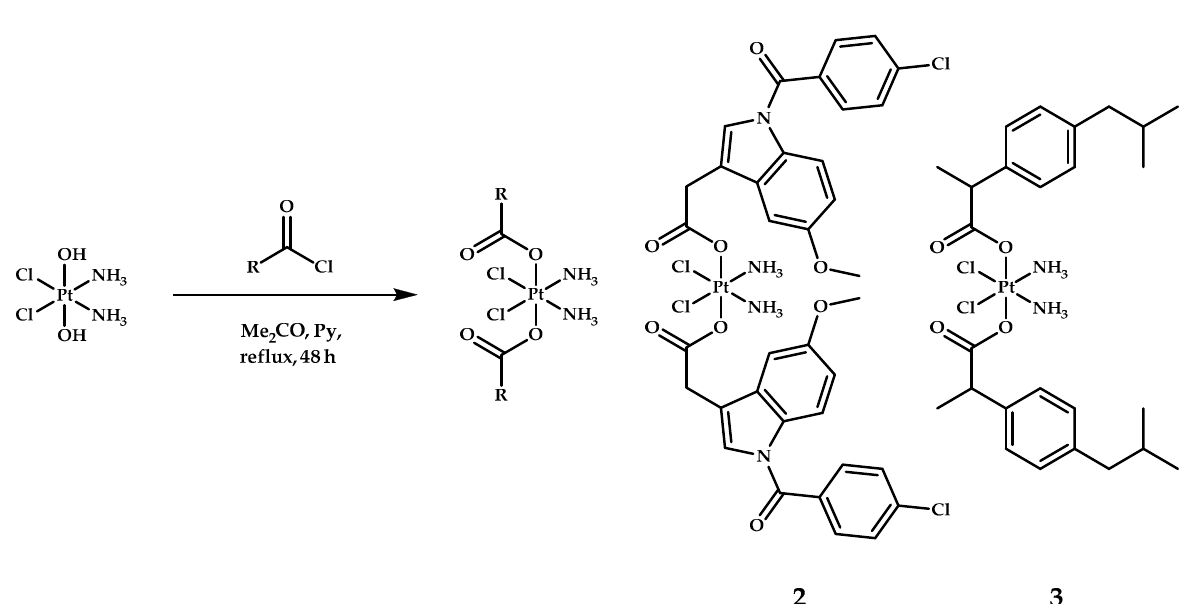
Figure 3. Synthesis of platinum(IV) prodrugs 2 and 3 with indomethacin and ibuprofen as the axial ligands.